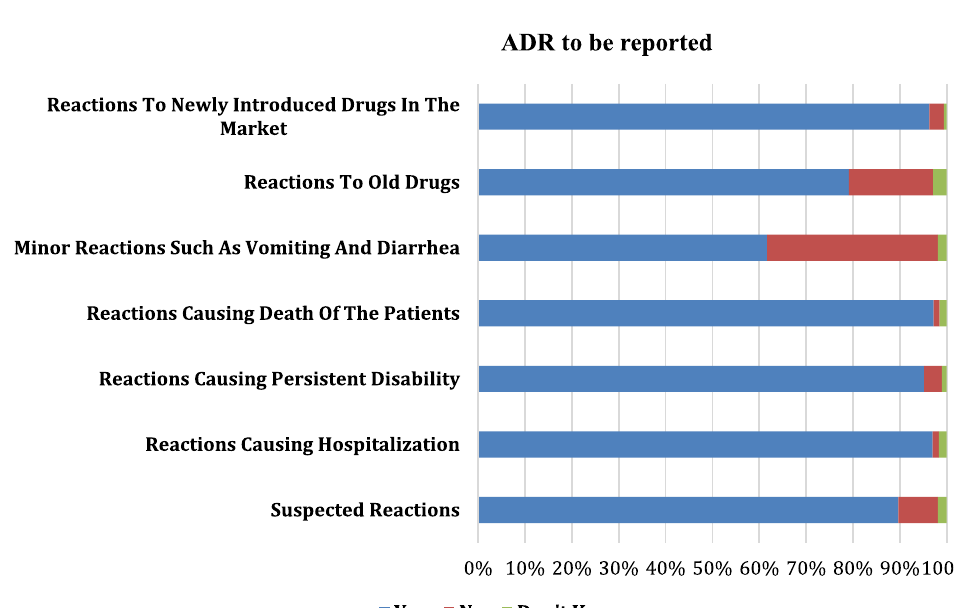
Fig. 1 Knowledge score of pharmacovigilance and ADR reporting among the participants ( n knowledge of PV and ADR reporting, while a 7.5% had poor knowledge